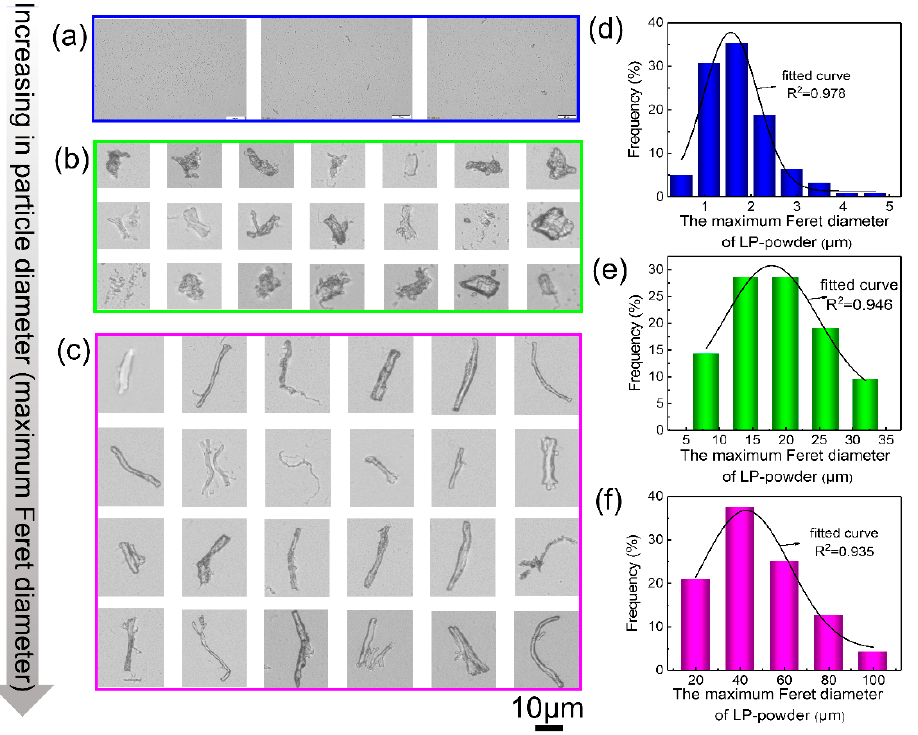
Figure 4. ( a – c ) Morphologies of the dot-like ( a ), rod-like ( b ), and fiber-like ( c ) particles; ( d – f ) histograms of the maximum Feret diameter of the dot-like ( d ), rod-like ( e ), and fiber-like ( f ) particles.